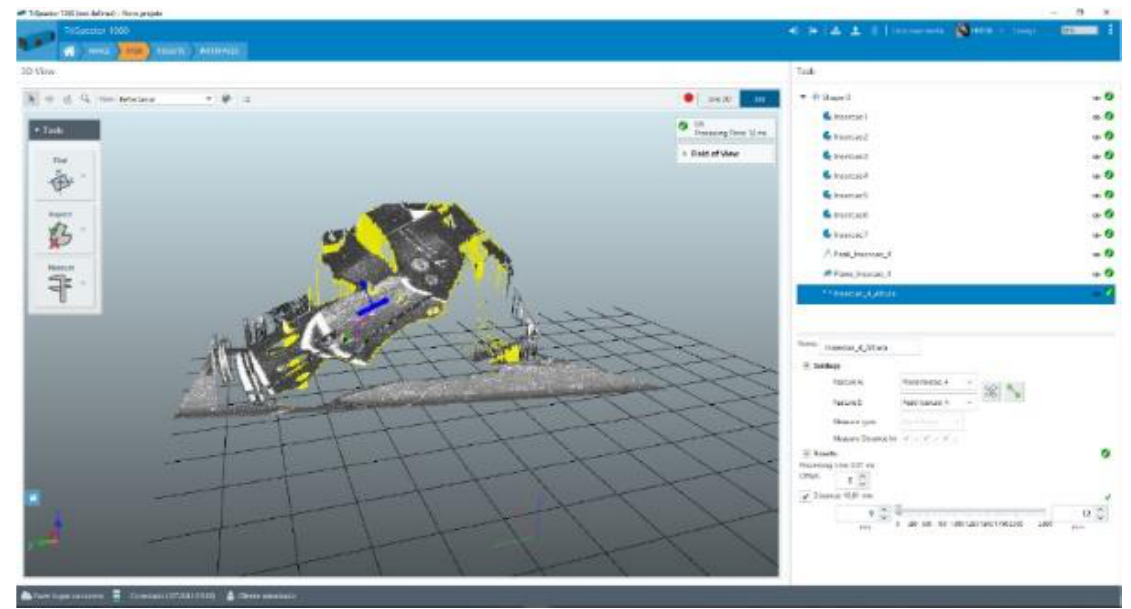
Figure 4. SOPAS Engineering Tool application for the TriSpector1000 system.